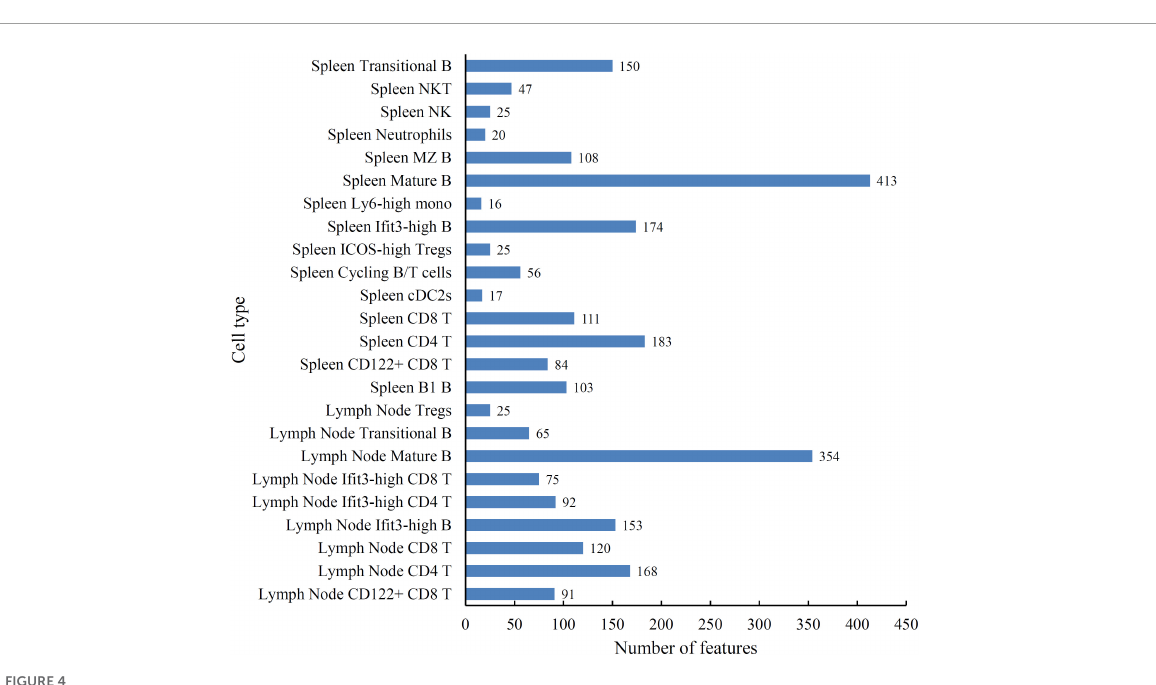
FIGURE4 Bat chart to show the number of rules for each cell